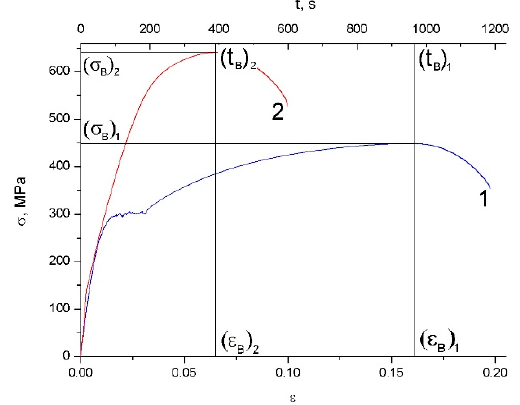
Figure 2. Loading diagrams for 0.2 С steel: 1—initial state; 2—after operation 219 thousand hours.